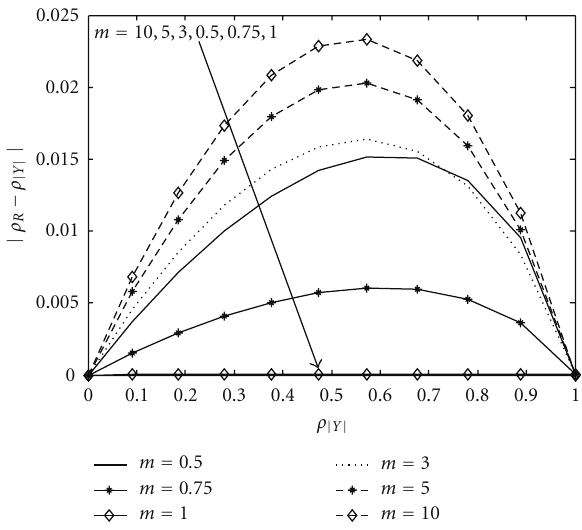
Figure 3: The absolute error between ρ R ( τ ) and ρ | Y | ( τ ).